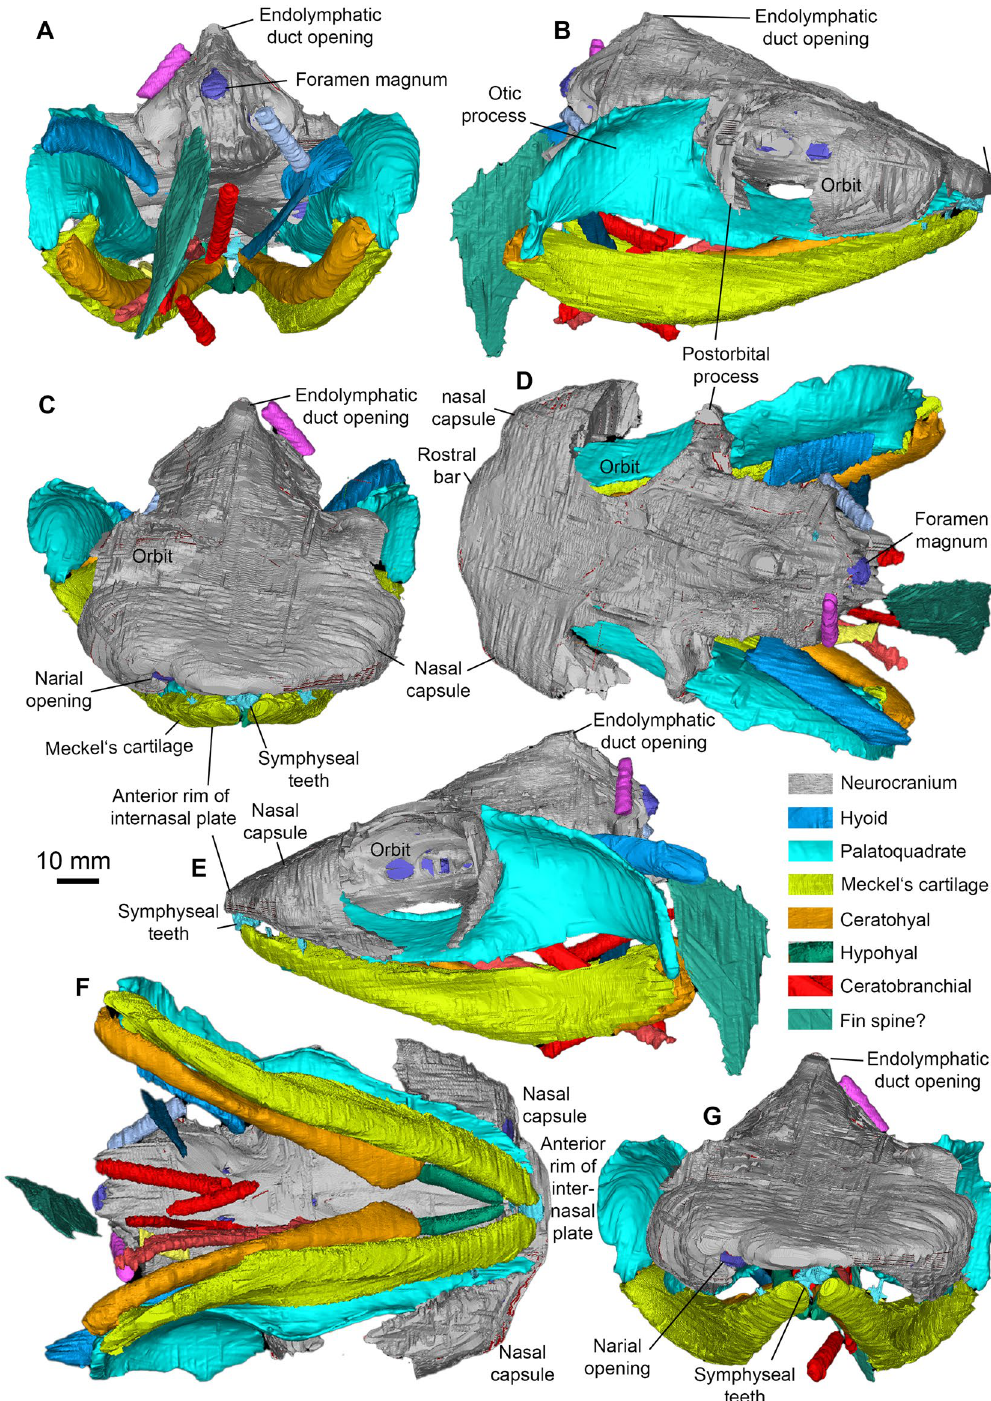
Fig. 5 Head of Maghriboselache mohamezanei n. gen. et sp., PIMUZ A/I 5156 with neurocranium, jaws, hyoid arches and disarticulated gill remains. A posterior, B right lateral, C anterior, D dorsal, E left lateral, F ventral, G anterior views. Note the color-coded cranial